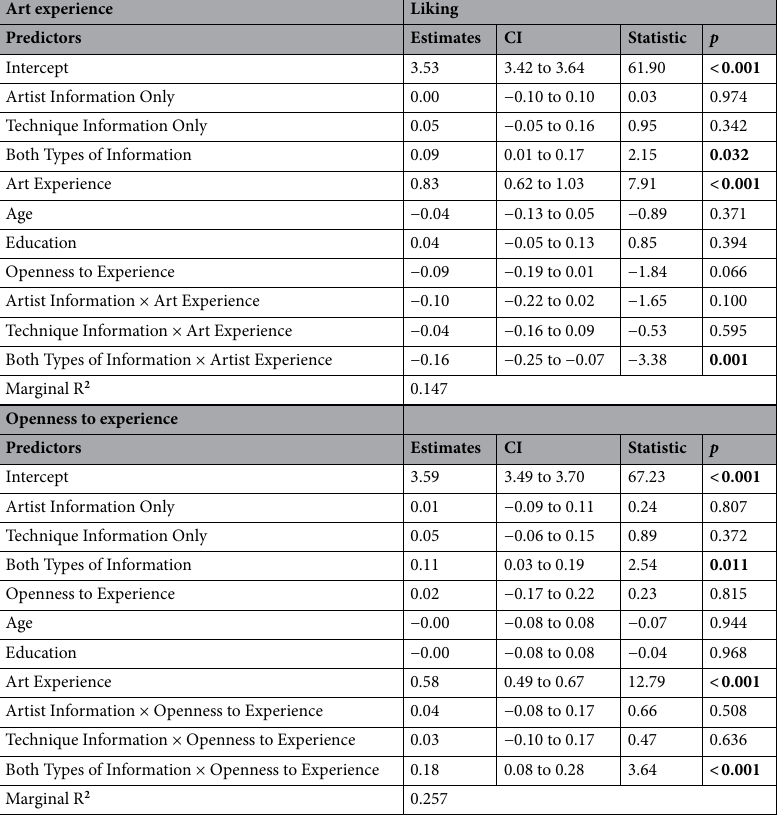
Table S2-S5 show beta estimates, confidence intervals, and p-values for all predictors for all models for all ratings. Table 2 provides information for liking ratings for the art_experience and openness_experience models in the main text. As the art_experience model includes fixed effects from the info_type model, we include